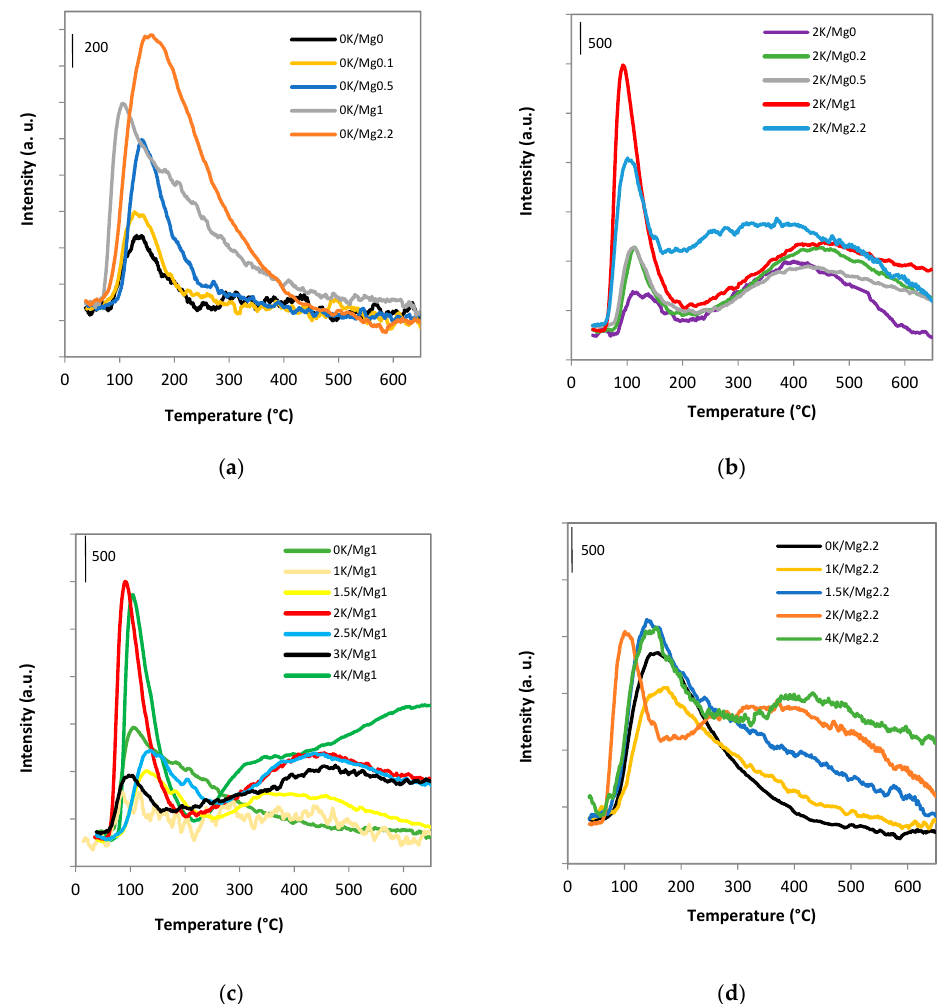
Figure 7. Temperature-programmed desorption of CO 2 (TPD-CO 2 ) of K/Co-Mg-Mn-Al mixed oxide catalysts: ( a ) 0K/Mg i catalysts, ( b ) 2 K /Mg i catalysts, ( c ) a K/Mg1 catalysts, and ( d ) a K /Mg2.2 catalysts.